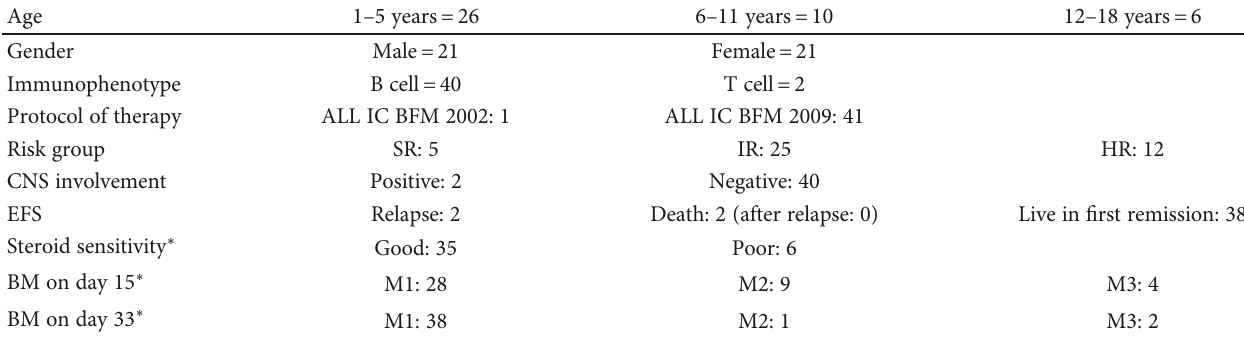
Table 1: Patient characteristics ( n = 42